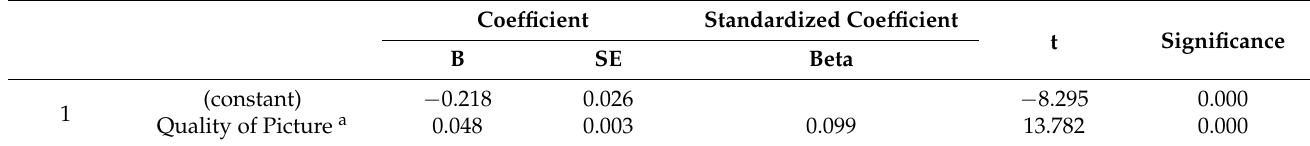
Table 11. Results of Test 3.